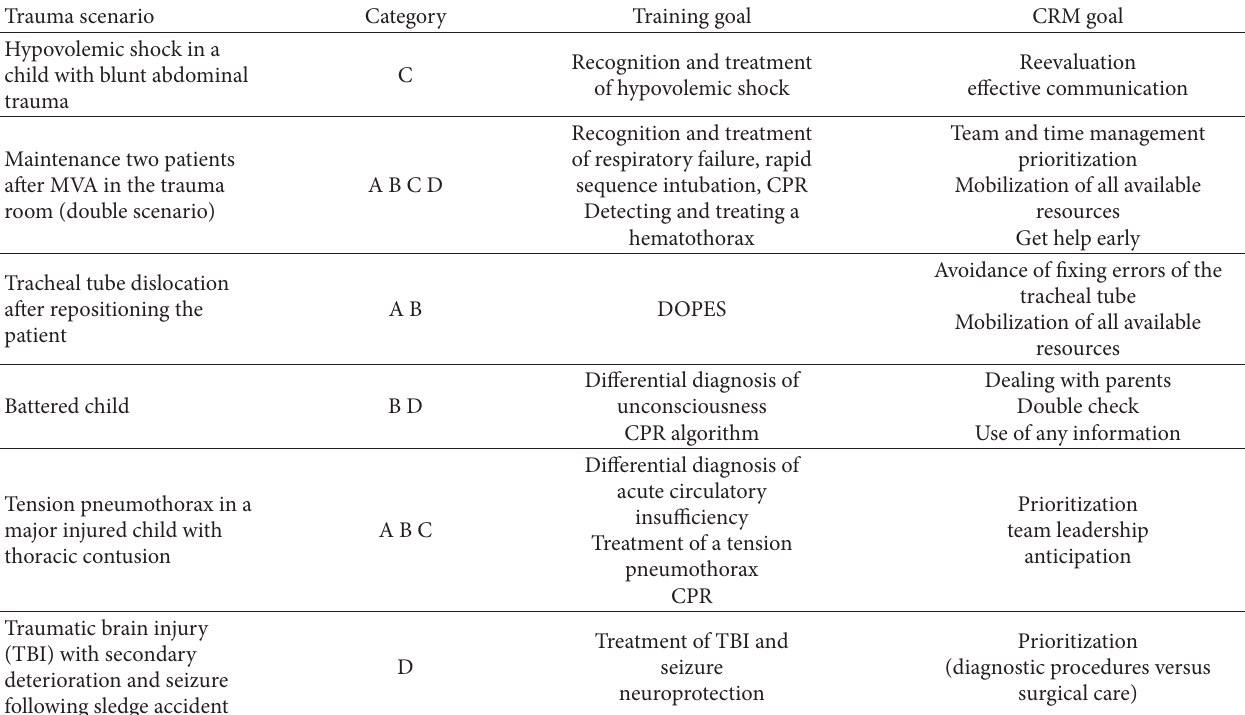
Table 1: The different scenarios with their respective medical and CRM priorities.